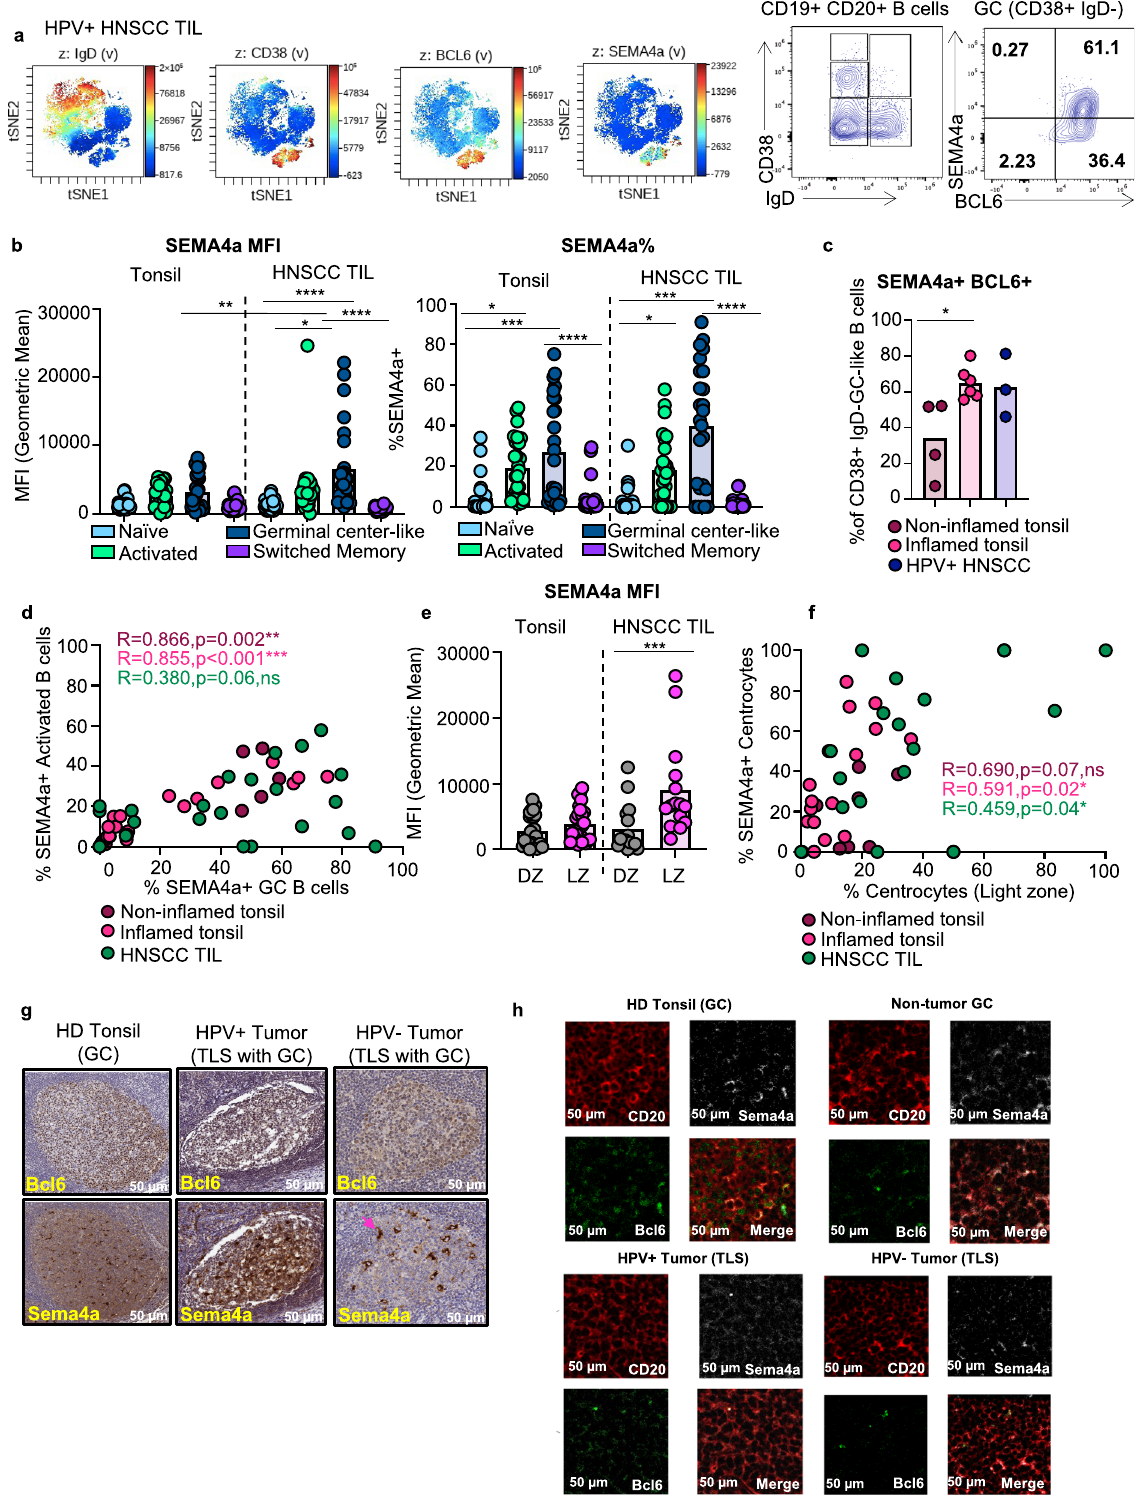
distinct from well-in fi ltrated tumors where immune cells are found in